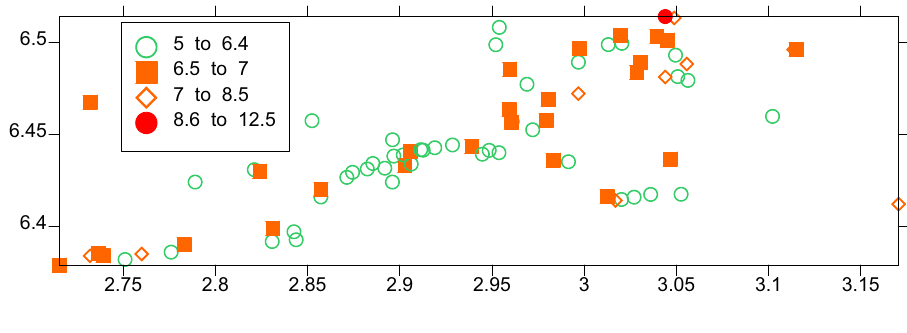
Fig. 20 Classed map of the pH in the study